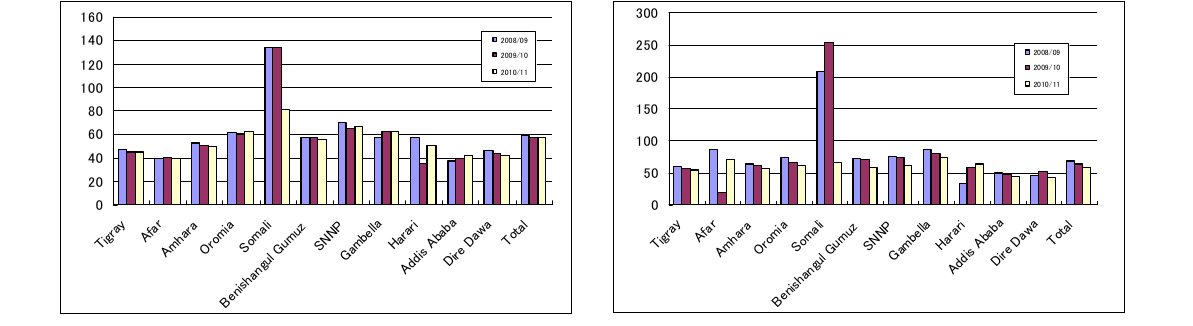
Figure 4-12: Primary Pupil Section Ration by Region (2008/09 - 2010/11)